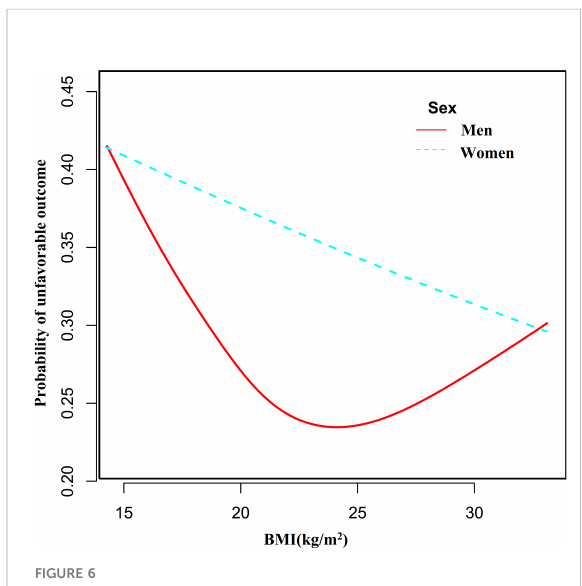
FIGURE 6 The nonlinear relationship between BMI and the probability of unfavorable outcomes in men and